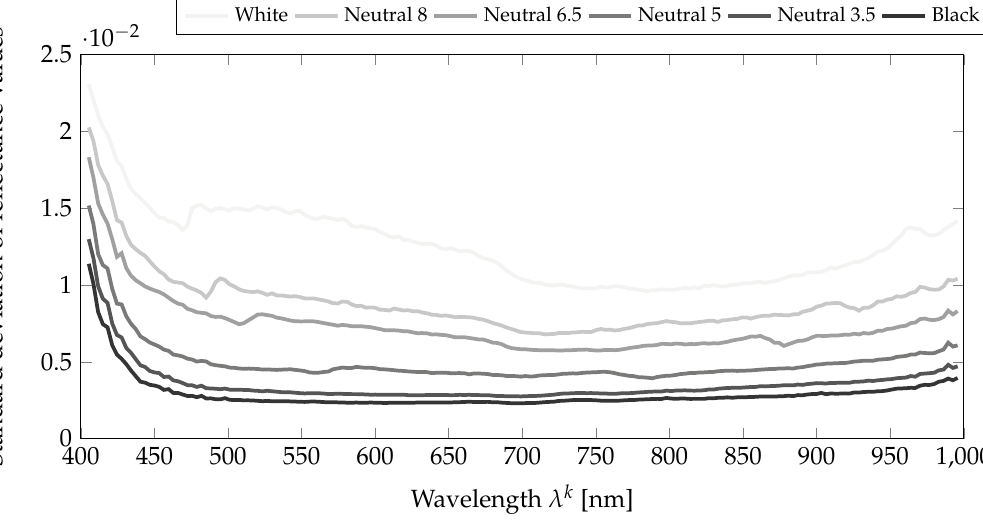
Figure 8. Standard deviations of spectral reflectances for 200 × 200 pixels of each gray patch of a Macbeth